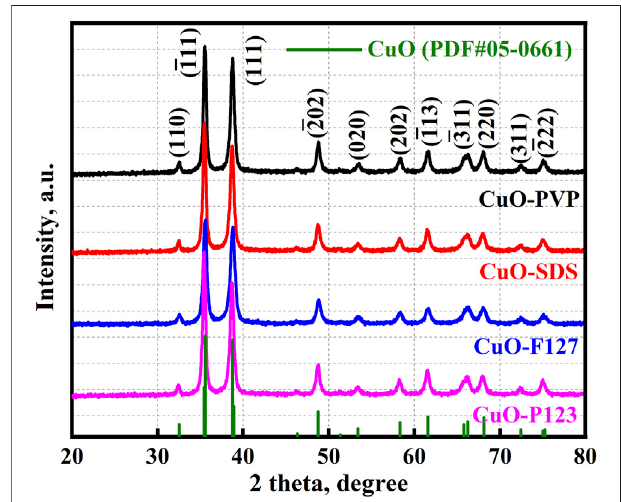
FIGURE1| XRDpatternsoftheCuOcatalystssynthesizedwithdifferent